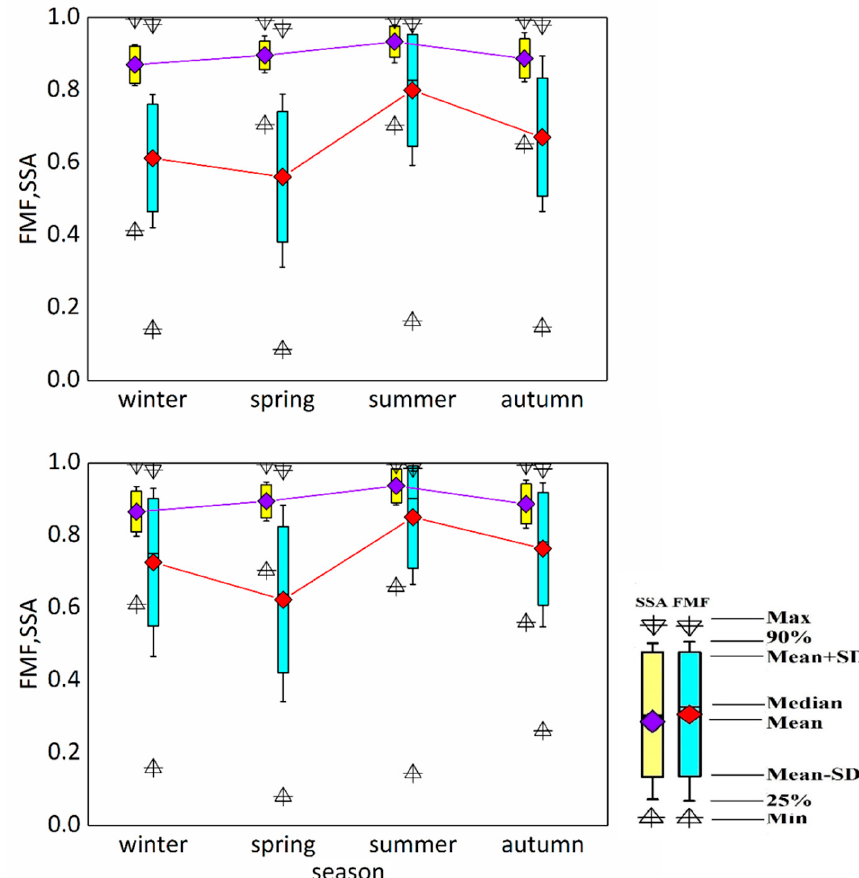
Figure 3. Seasonal variation of the aerosol types in BJ and XH.